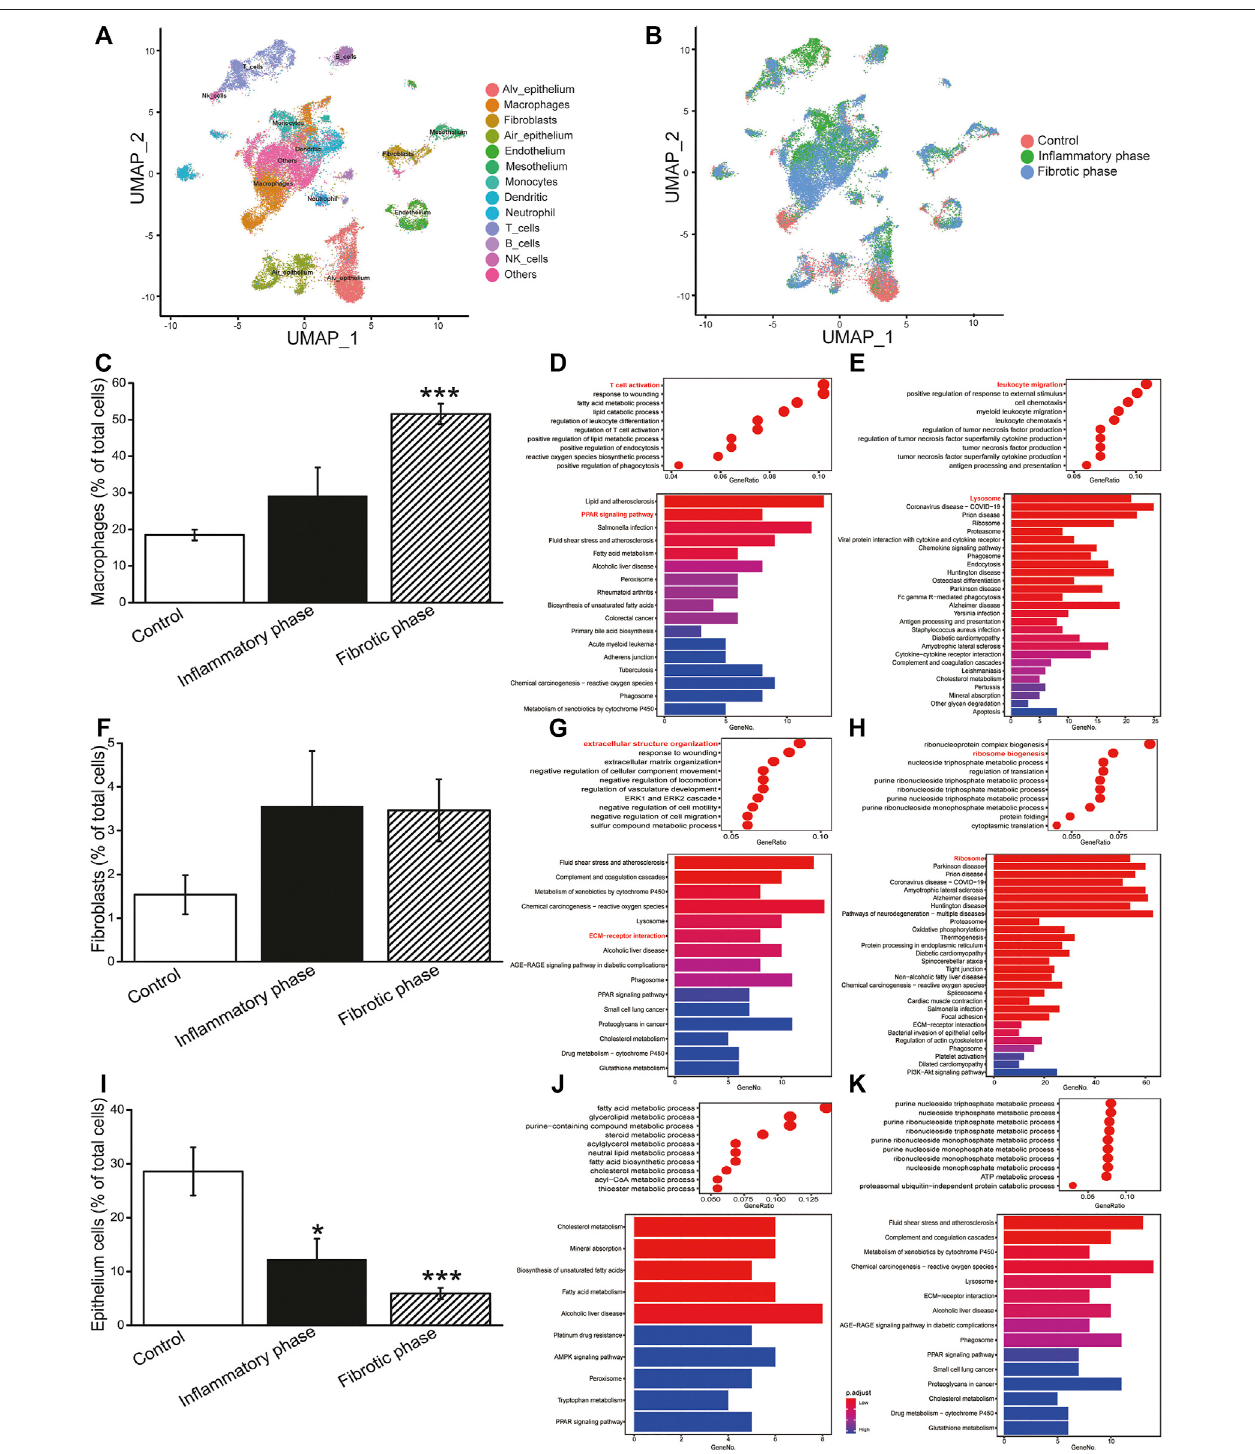
FIGURE 1 | ScRNA-seq analysis of BLM-induced PF. (A) Identi fi ed cell types in UMAP. (B) Cells split by in fl ammatory and fi brotic phases. (C) Percentage of macrophages. Bubble/bar plot showingGO/KEGG enrichment analysisresults of the (D) downregulatedand (E) upregulated genes inmacrophages. (F) Percentage of fi broblasts. Bubble/bar plot showing GO/KEGG enrichment analysis results of the (G) downregulated and (H) upregulated genes in fi broblasts. (I) Percentage of epithelial cells. Bubble/bar plot showing GO/KEGG enrichment analysis results of the (J) downregulated and (K) upregulated genes in epithelial cells. * p < 0.05, *** p < 0.001, versus the control group, by the Mann – Whitney U test.